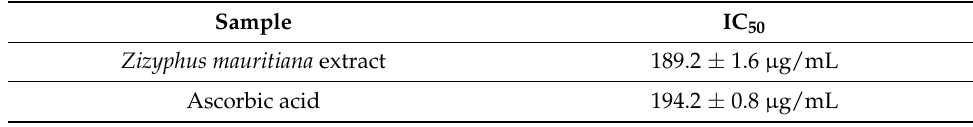
Table 1. H 2 O 2 radical scavenging activity of Z. mauritiana fruit extract.